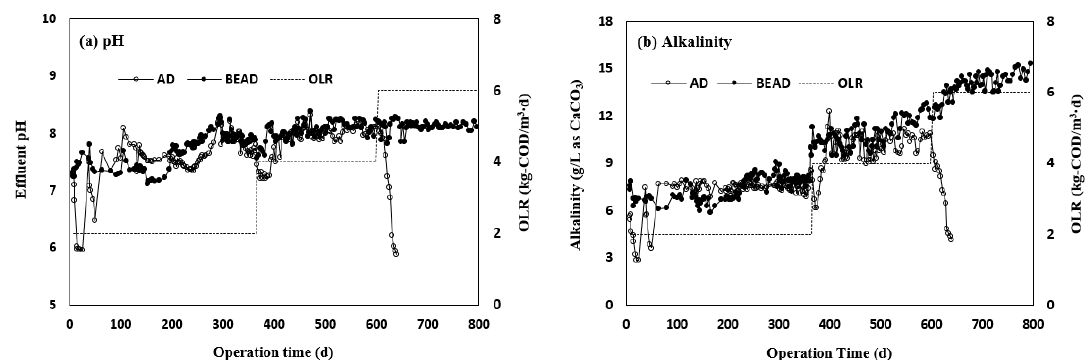
Figure 2. pH and alkalinity changes in AD and BEAD reactors at each OLRs stage.